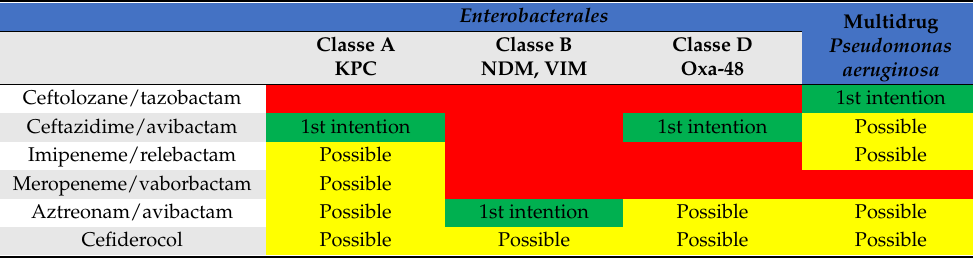
Table 1. Preferred and alternative treatment recommendations (adapted from IDSA 2022 [66]